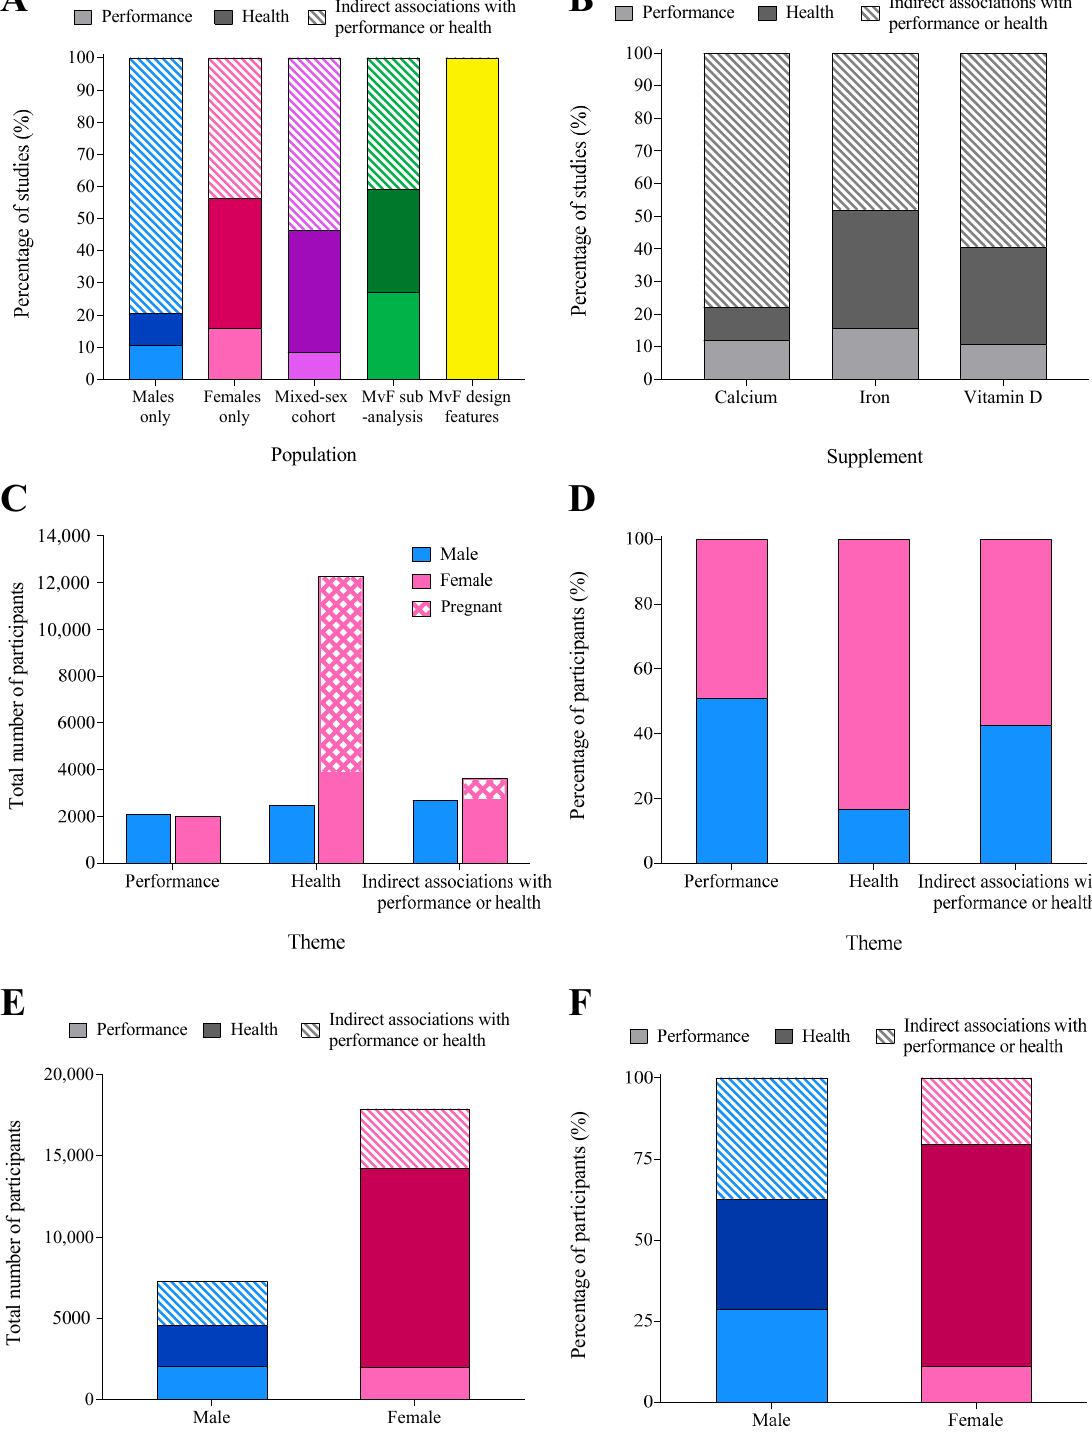
Figure 6. The percentage of studies in each theme: performance (direct performance outcomes), health (outcomes related to health status/condition), and indirect associations with performance/health (physiological or psychological adaptation/response that may subsequently transfer to athletic performance/health), separated by ( A ) population and ( B ) supplement. The total number ( C ) and proportion ( D ) of male and female participants in each research theme. The total ( E ) and proportion ( F ) of male and female participants involved in studies measuring outcomes of performance, health, or indirect associations with performance or health .